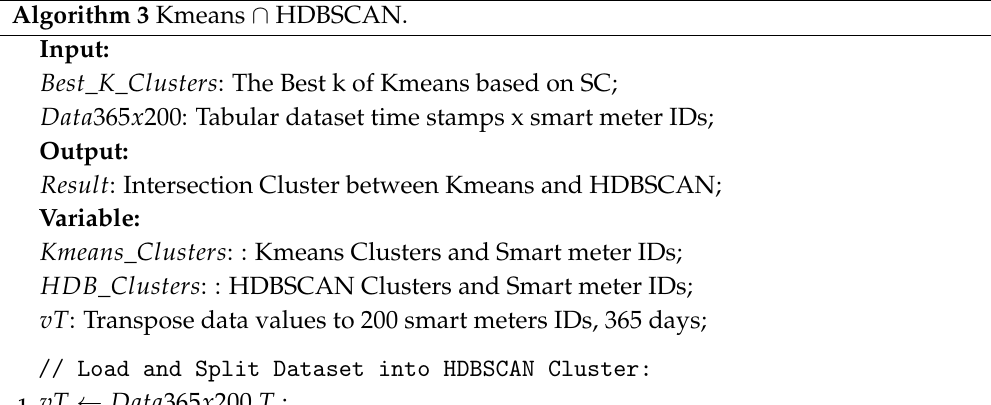
Algorithm 3 Kmeans ∩